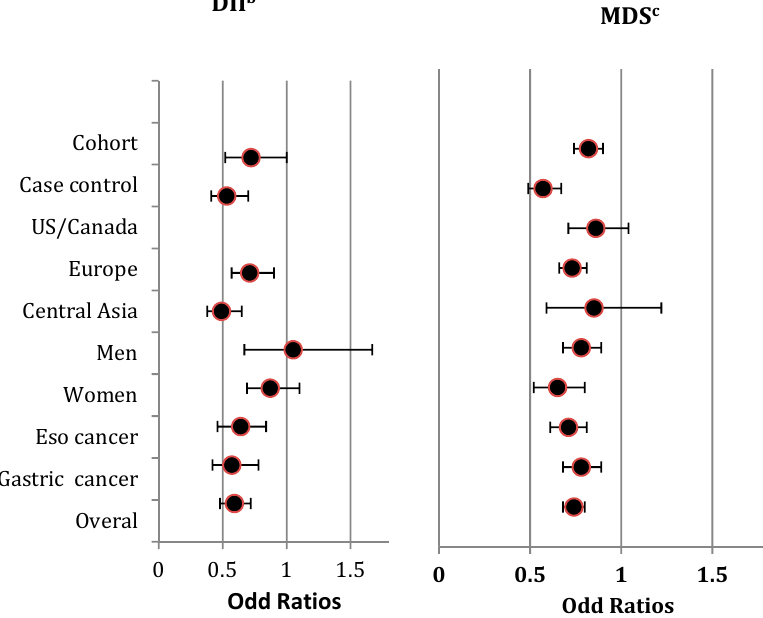
Figure 2. Summary risk estimates for highest diet quality compared to lowest diet quality concerning UGI cancers, stratified by study design (i.e., Cohort studies / Case-control studies) geographic region (i.e., US / Canada, Europe, Central Asia) gender (i.e., Men, Women), tumour site (i.e., Esophagus cancer, Gastric cancer) and overall estimate a . a The Summary risk estimates are from pooling the reported ORs by included studies for the highest diet quality compared to the lowest, measured by DII and MDS with respect to UGI cancers. b The lowest categories of DII measure the highest diet qualities, and the highest categories of DII measure the lowest diet quality. c The highest categories of MDS measure the highest diet qualities, and the lowest categories of MDS measure the lowest diet